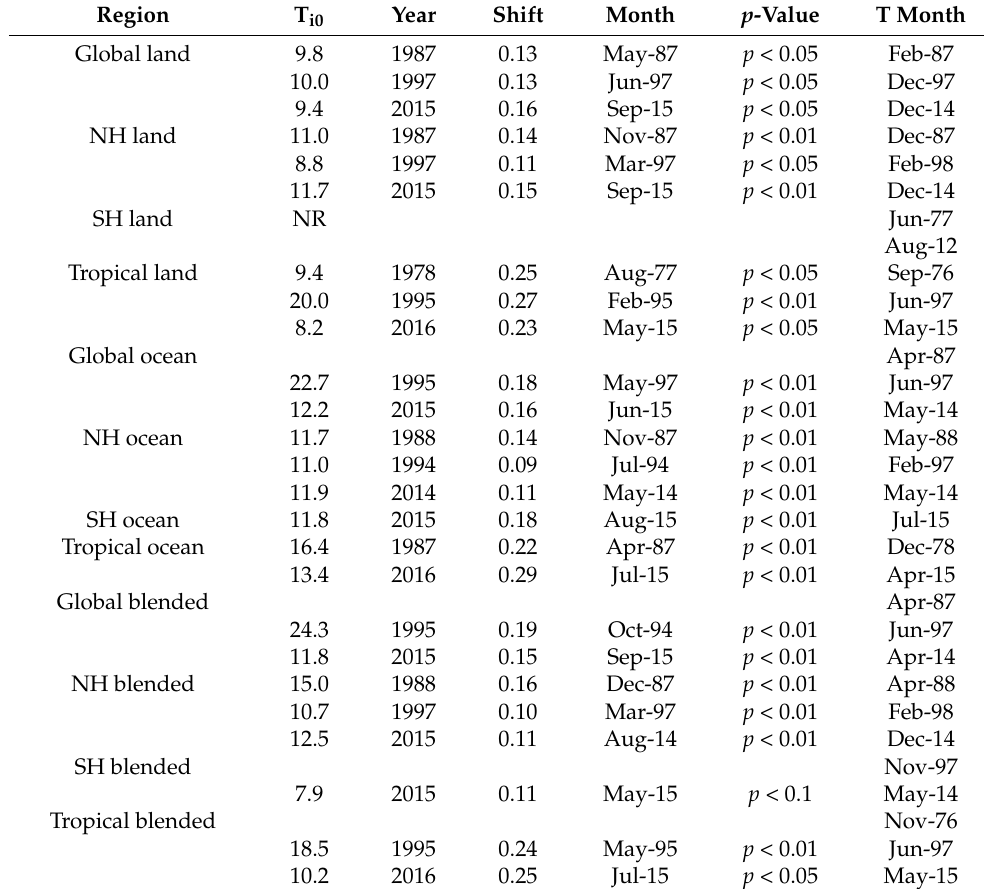
Table 1. Bivariate test result (T i0 ), year of shift, month of shift, p -value for regime changes in specific humidity (g kg − 1 ) and month of shift in temperature from HadISDH data.